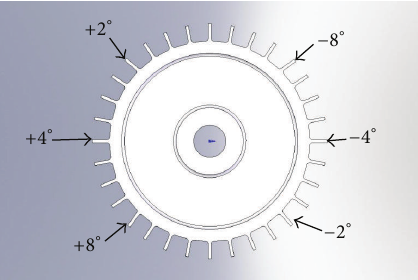
Figure 5: Simulated turbine disk with prebent blades for blade tip deflection